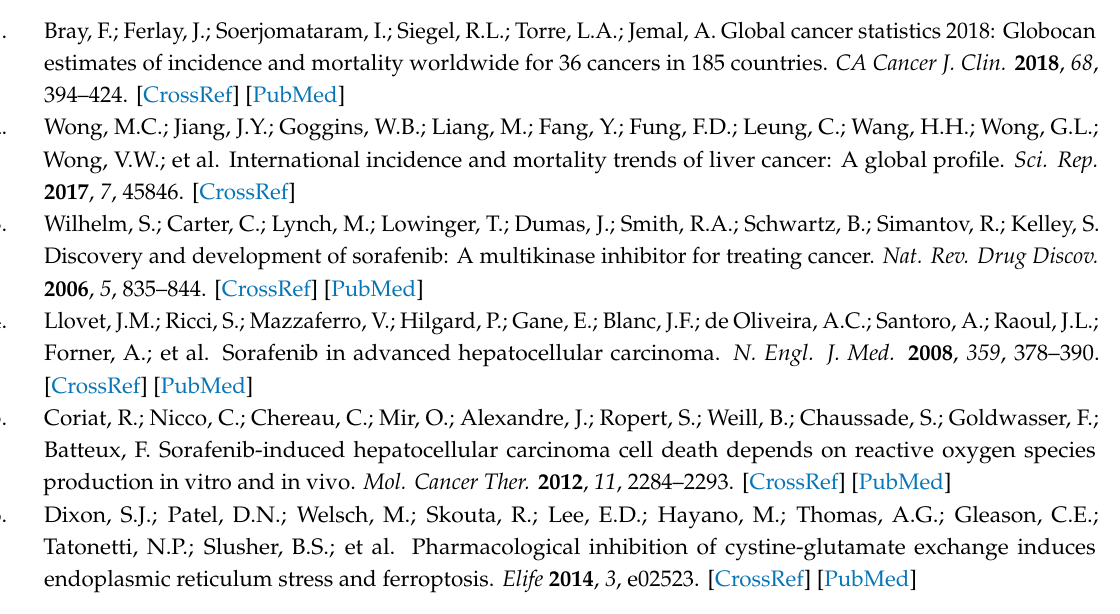
Figure S1: Dose and time e ff ects of sorafenib and diclofenac on HCC cell growth, Figure S2: E ff ect of Z-VAD-FMK, chloroquine and necrostatin-1 on sorafenib / diclofenac-induced HCC cell